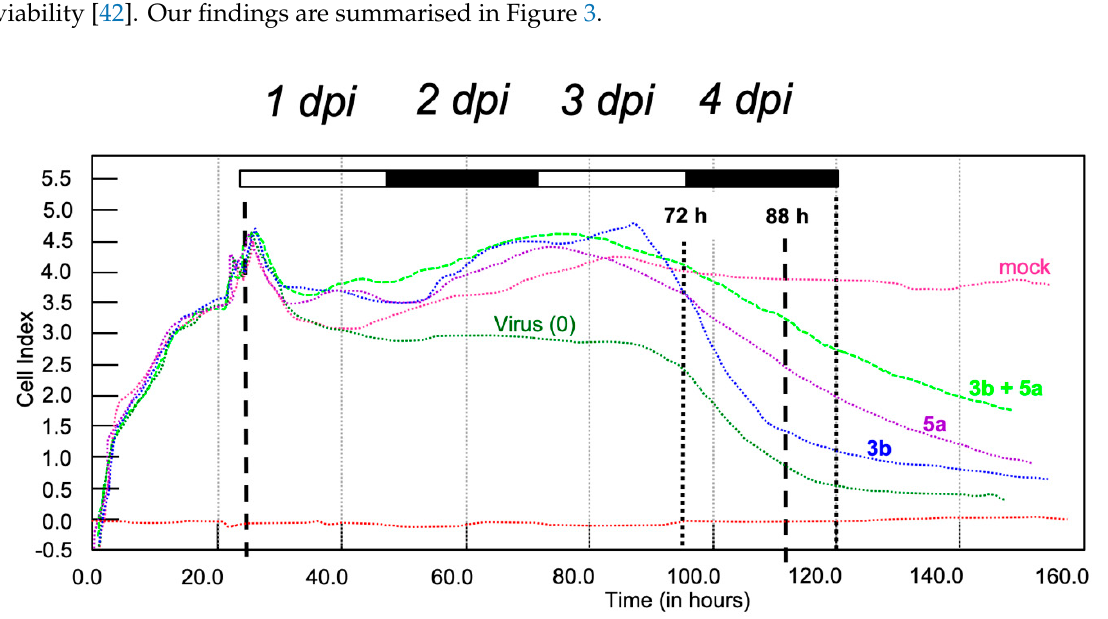
Figure 3. The effect of 3b (blue), 5a (purple), and a combination of both (light green) was tested at a concentration of 20 µ m against ZIKV in A-549 cells plated in a 16 well CIM-Plate 16 using the xCELLigence RTCA DP Instrument. No compound (dark green; 0) and mock (no virus, pink) were used as controls. Dpi: days postinfection.